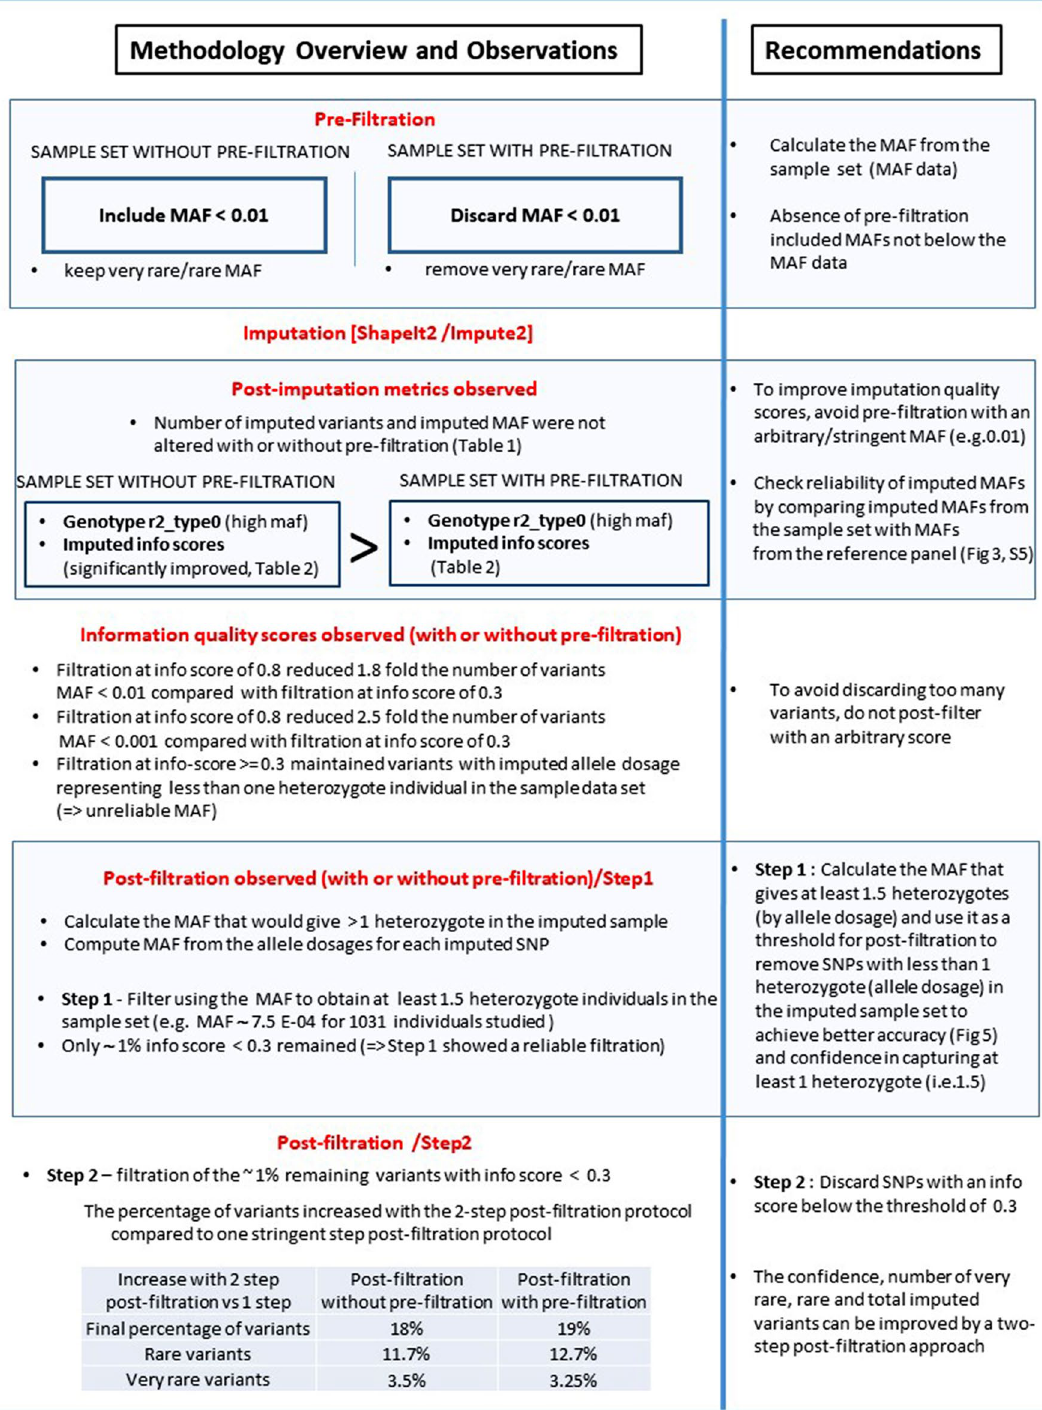
the imputation runs. The 2 Mb region in terms of counts, density and MAFs of SNPs was representative of the 2 Mb bins of Chr20 and the whole genome (Supplementary Fig.S1, S2, Table S1).